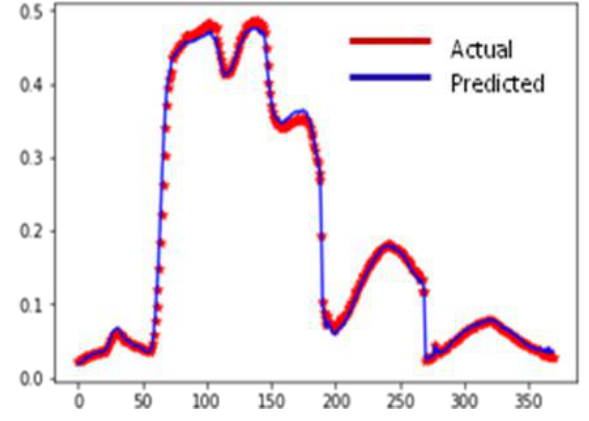
Figure 5. Spectral profile of original and reconstructed image in case of reconstruction using one node in bottleneck layer